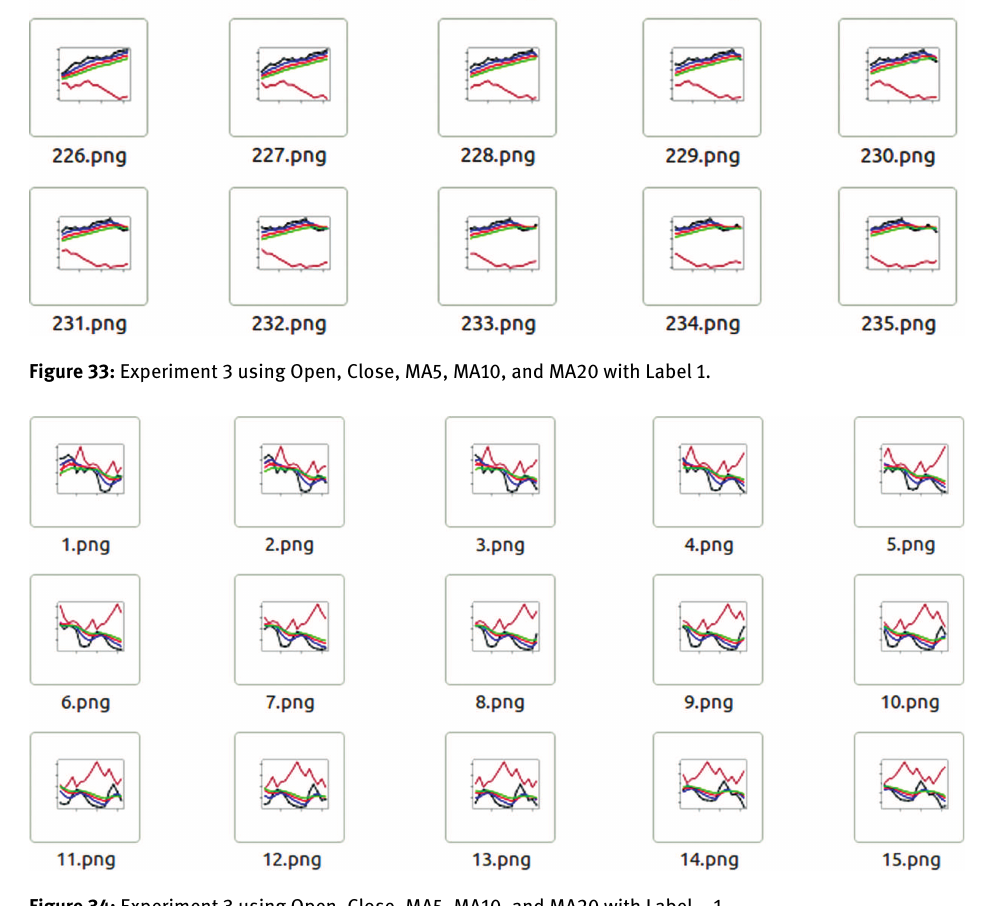
Figure 34: Experiment 3 using Open, Close, MA5, MA10, and MA20 with Label − 1.